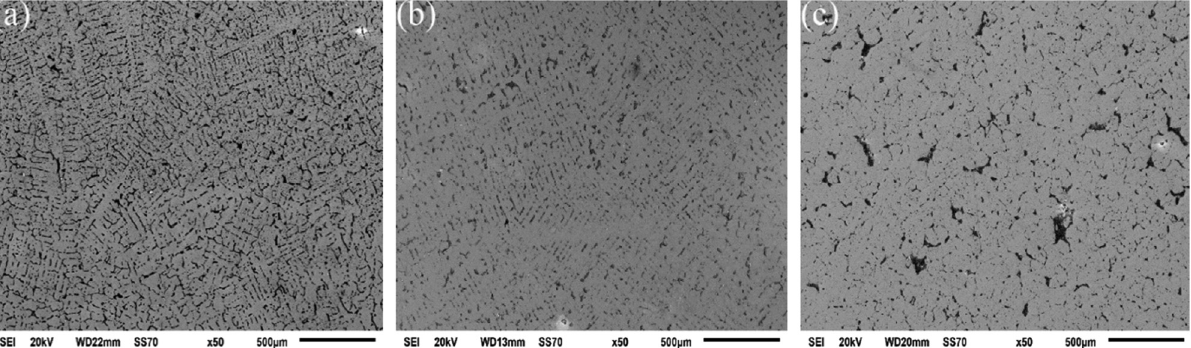
Figure 3: Changes in solidi fi cation microstructures of Cu – 37.4 wt% Pb alloys with di ff erent ECP treatments: ( a ) I = 800 A, ( b ) I = 1,000 A, and ( c ) I = 1,200